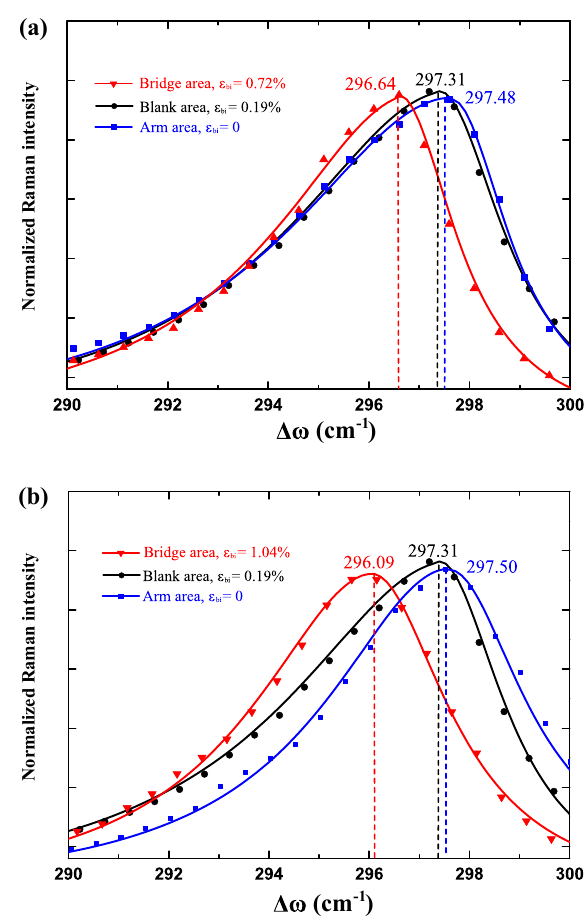
Figure 4: (a) Raman peaks of the device with 0.72% biaxial tensile strain in the cap layer. (b) Raman peaks of the device with 1.04% biaxial strain in the cap